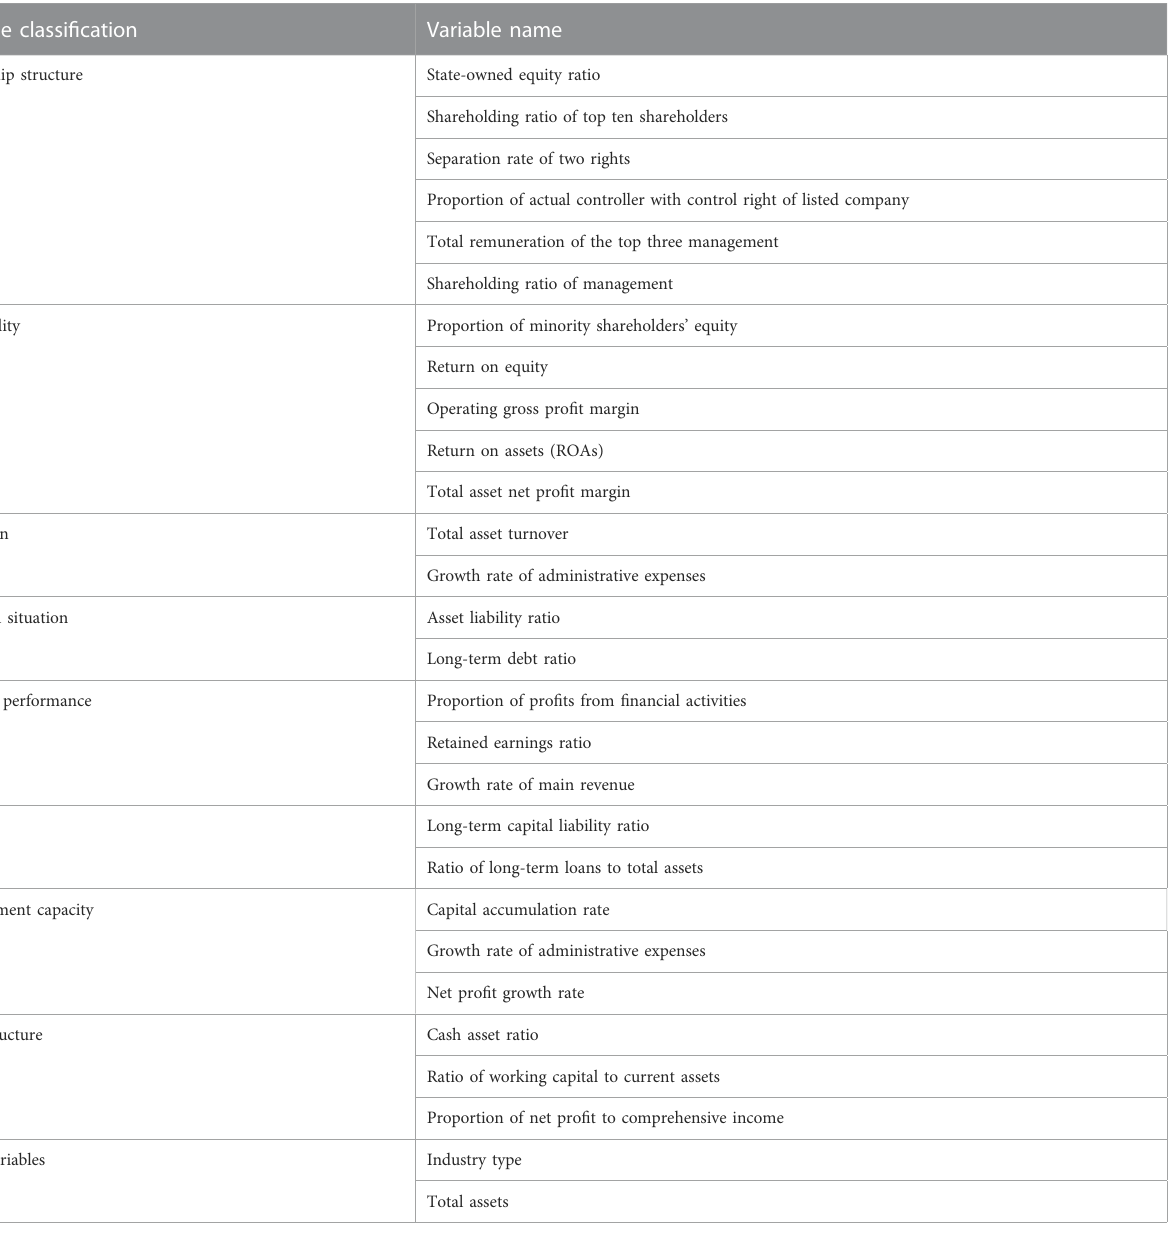
TABLE 3 Variable classi fi cation table. Variable classi fi